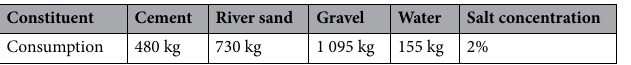
Table 1. Concrete mixture proportion.